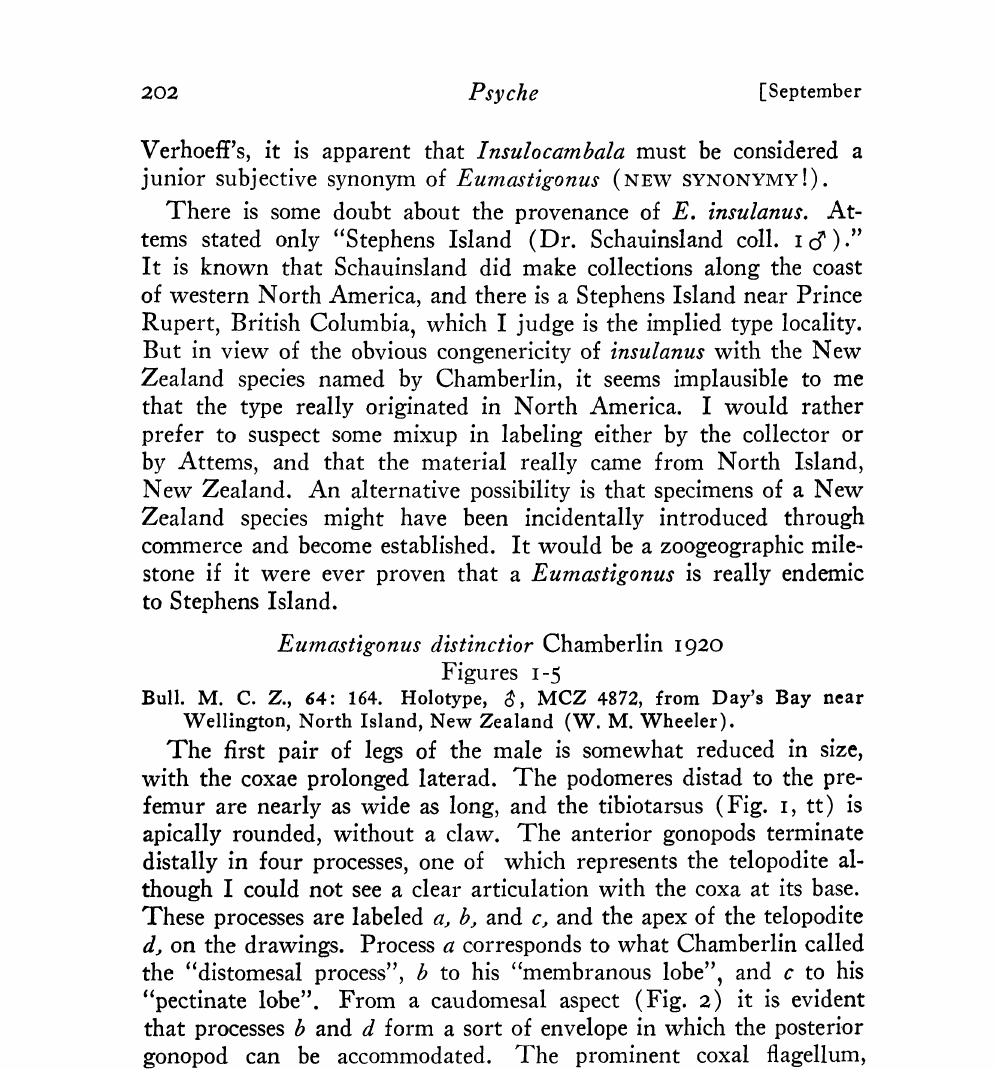
Figs. 1-5. Eumastigonus distinctior Chamberlin, from male holotype. Fig. 1. First pair of legs, gnathoehilarium, and part of mandible, right side, aboral aspect. Fig. 2. Gonopods, oral aspect (let posterior gonopod not shown). Fig. 3. Right anterior gonopod, oblique eaudomesal aspect. Fig. 4. Right anterior and posterior gonopods, lateral aspect (traeheoeoal muscle shown, others removed for clarity). Fig. 5. Apical third of right posterior gonopod, oral aspect, showing apparent basal articulation of an- terior distal process (telopodite